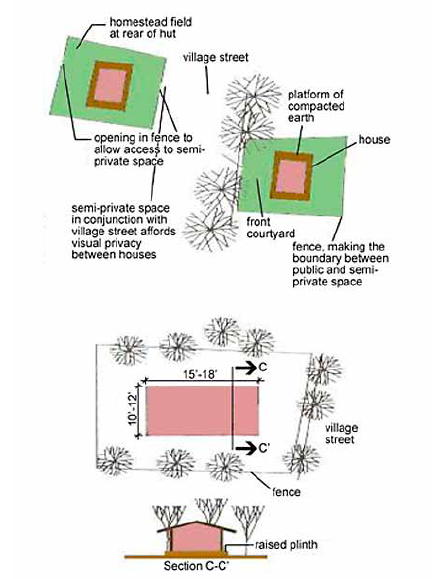
fig. 3. Typical layout of huts in jharkhand (reproduced from Dhar 1992)